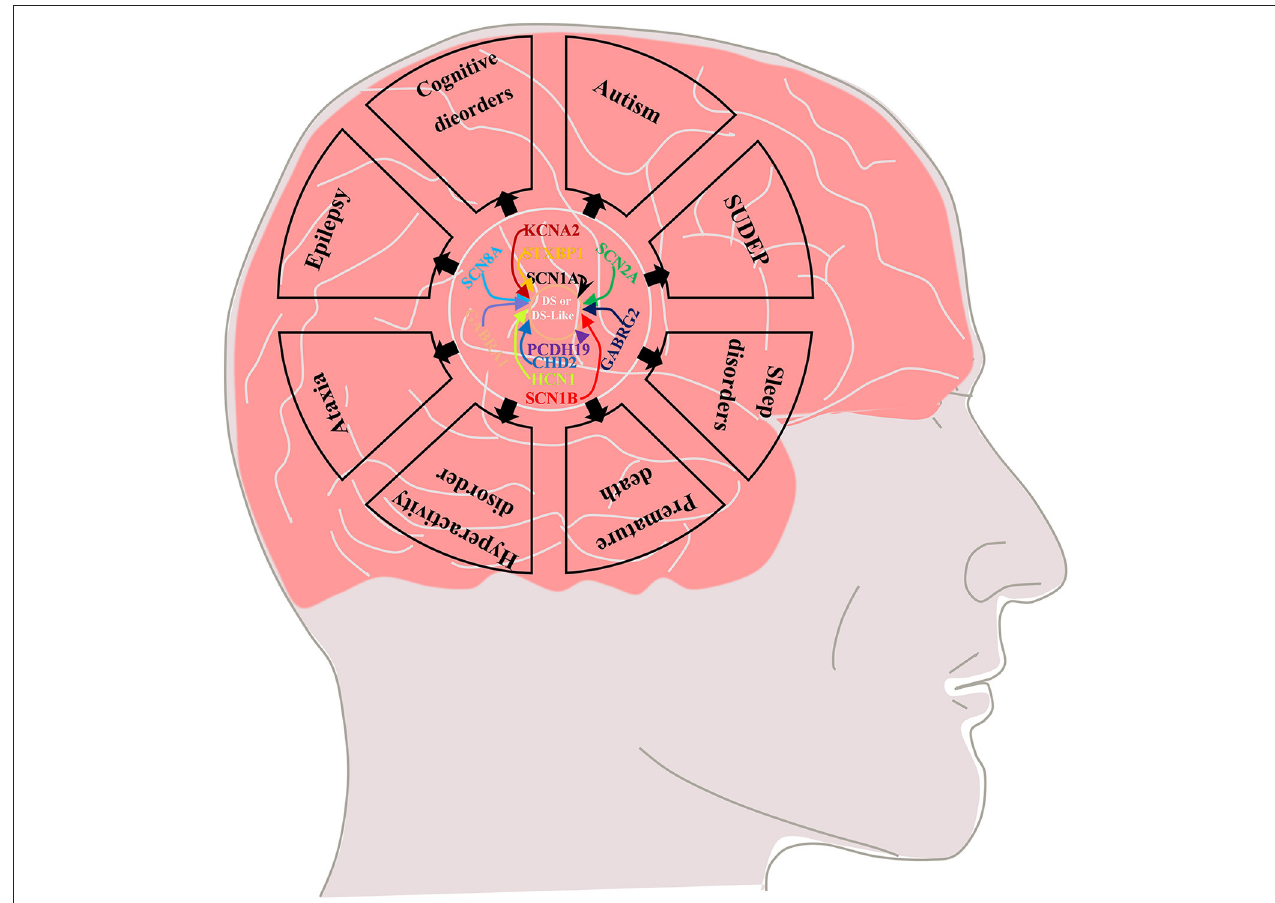
FIGURE 1 | Multiple genetic mutations cause DS or DS-like phenotypes and lead to epilepsy and its comorbidities including cognitive dysfunction (motor, language, and intellectual deficits), autistic behavior, ataxia, sleep disorders, SUDEP and premature